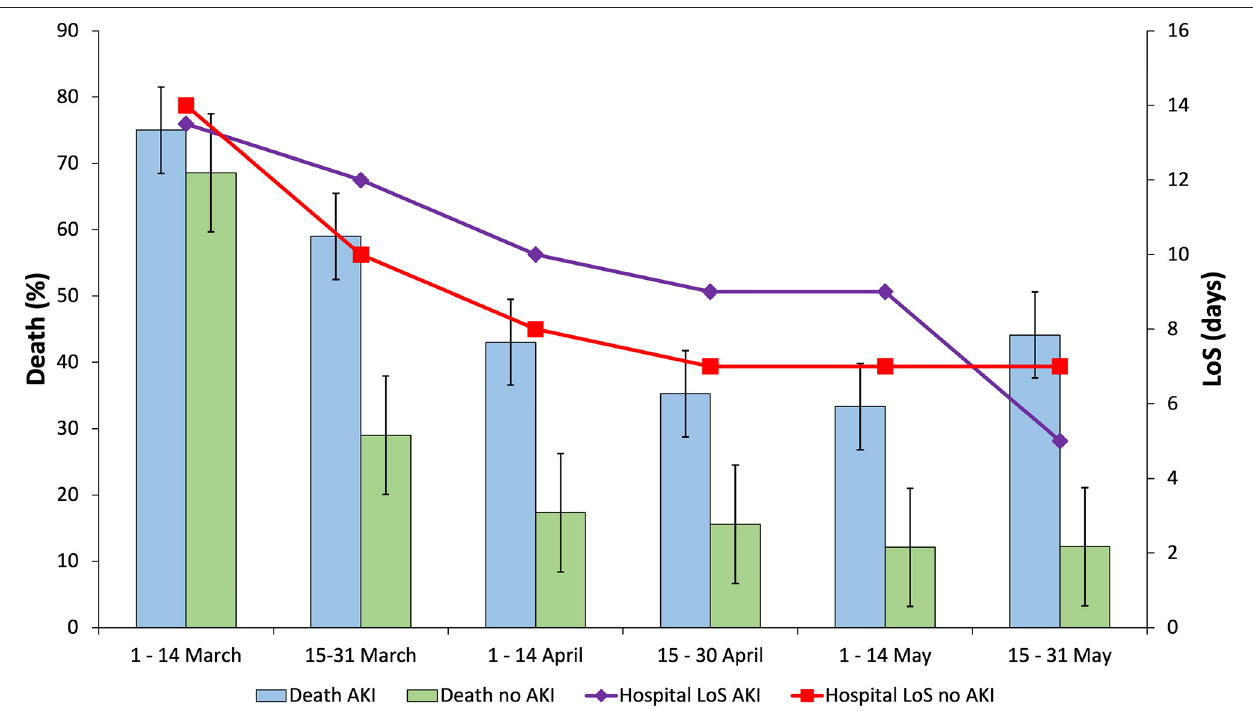
FIGURE 1 | Death and hospital length of stay (LoS) corresponding to the in-hospital COVID-19 patients with or without acute kidney injury (AKI) in Castile and Leon (Spain) (March 1st–May 31th,